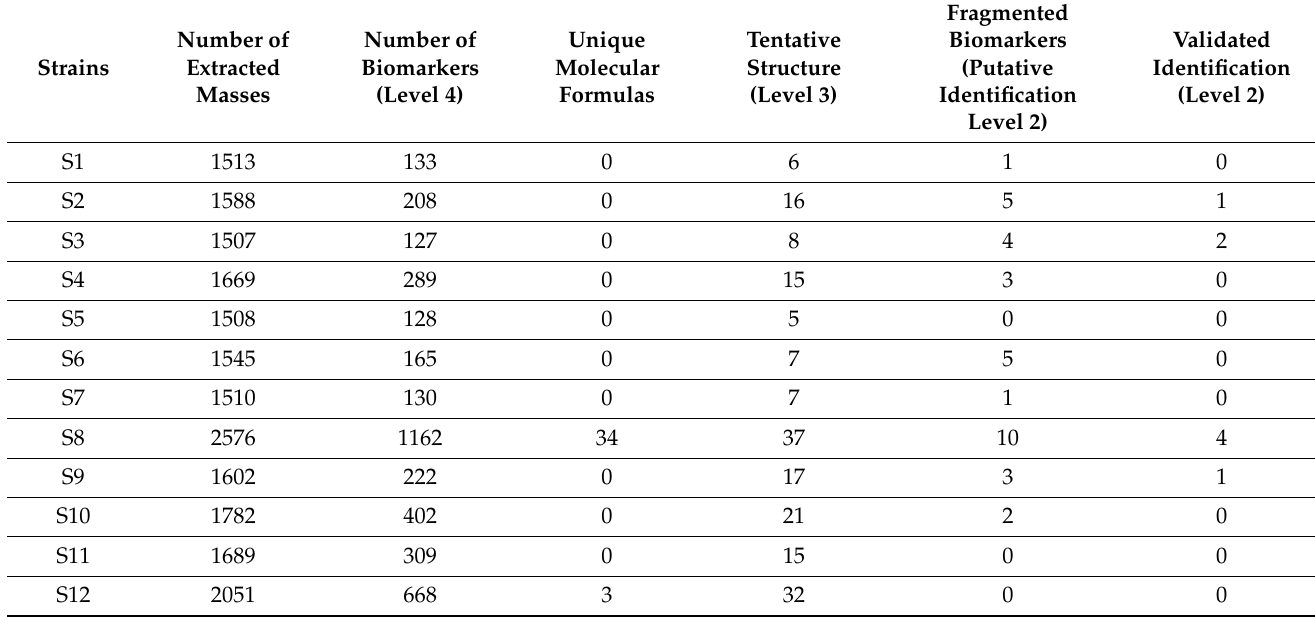
Table 1. Table of extracted, annotated, and identified metabolites according to wine fermented by each strain of Saccharomyces cerevisiae (S1 to